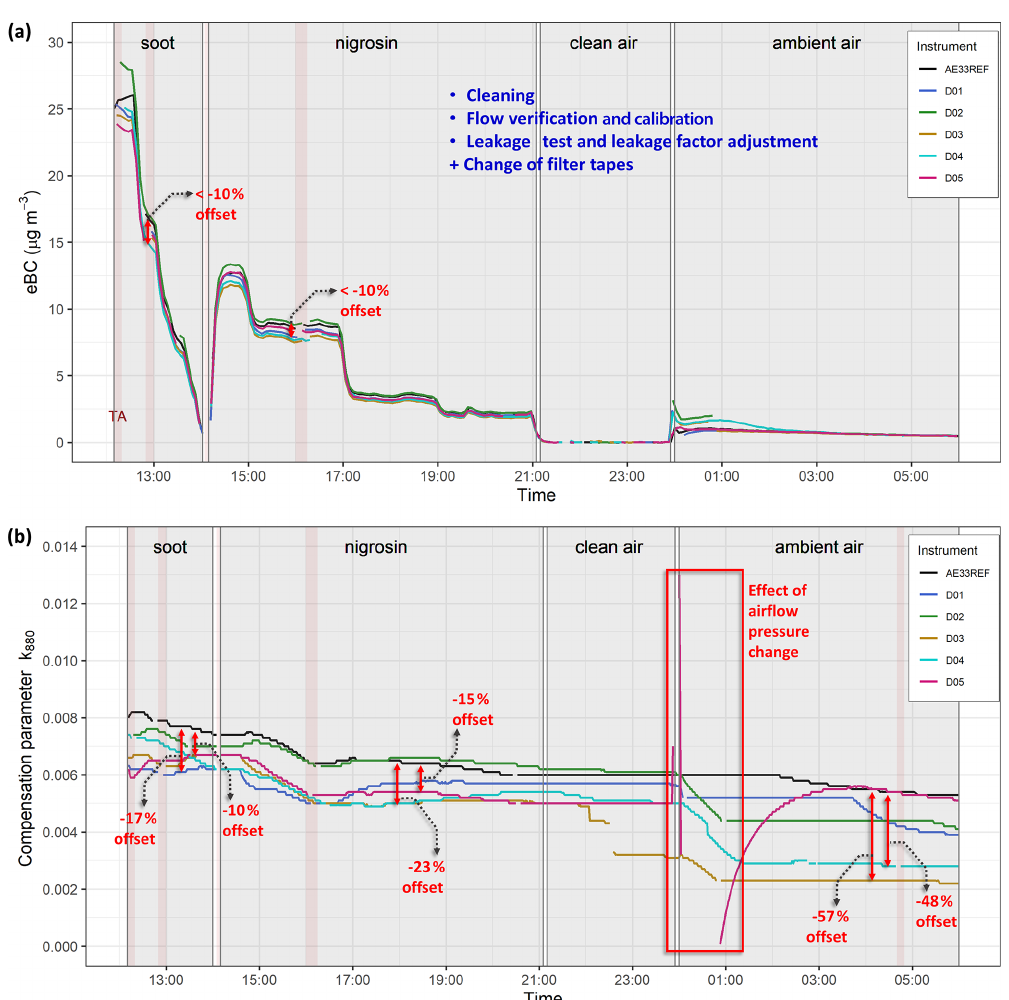
Figure 8. Time series of (a) eBC mass concentrations at 880nm and (b) compensation parameters k 880 after the final phase of maintenance in group D. Areas outlined in gray show the periods of clean air and aerosol supply; red bars indicate times when tape advances occurred in more than one instrument